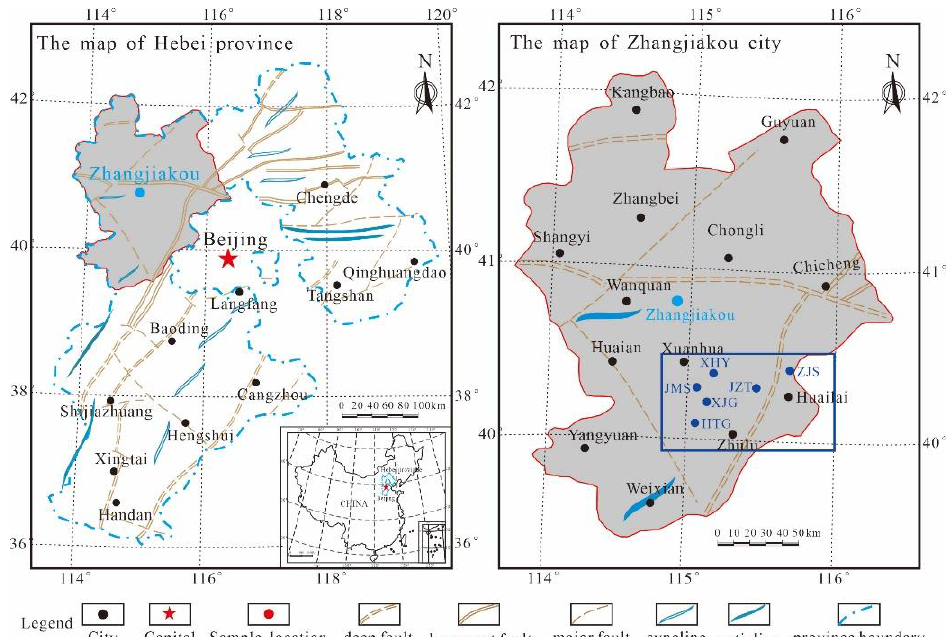
Figure 1. Structural outline of the research area and the sampling point locations.